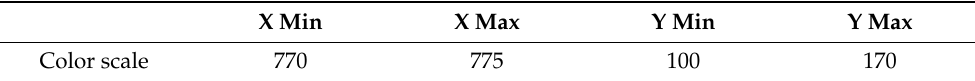
Figure 3. B-mode, Contrast mode, and color scale coordinates determination from one frame. Each part is marked by a rectangle with red edges. Table 3. Coordinates determined experimentally for the color